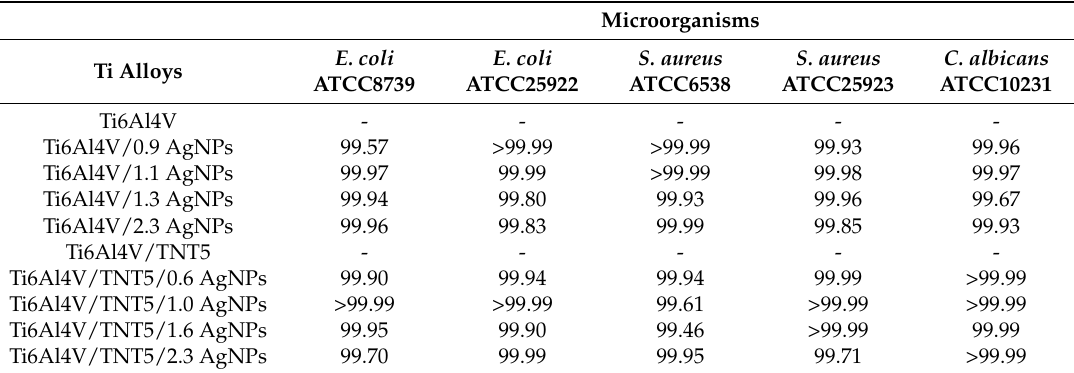
Key: -; no reduction (control). PBS: phosphate buffered saline solution.